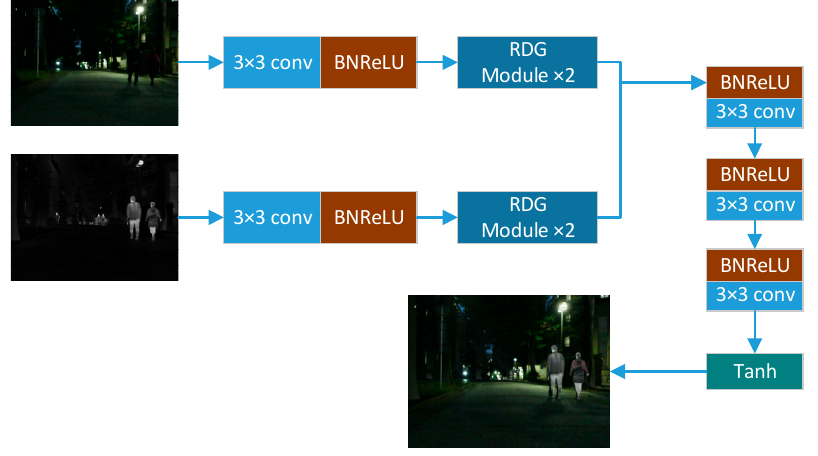
Figure 3. The fusion part network internal